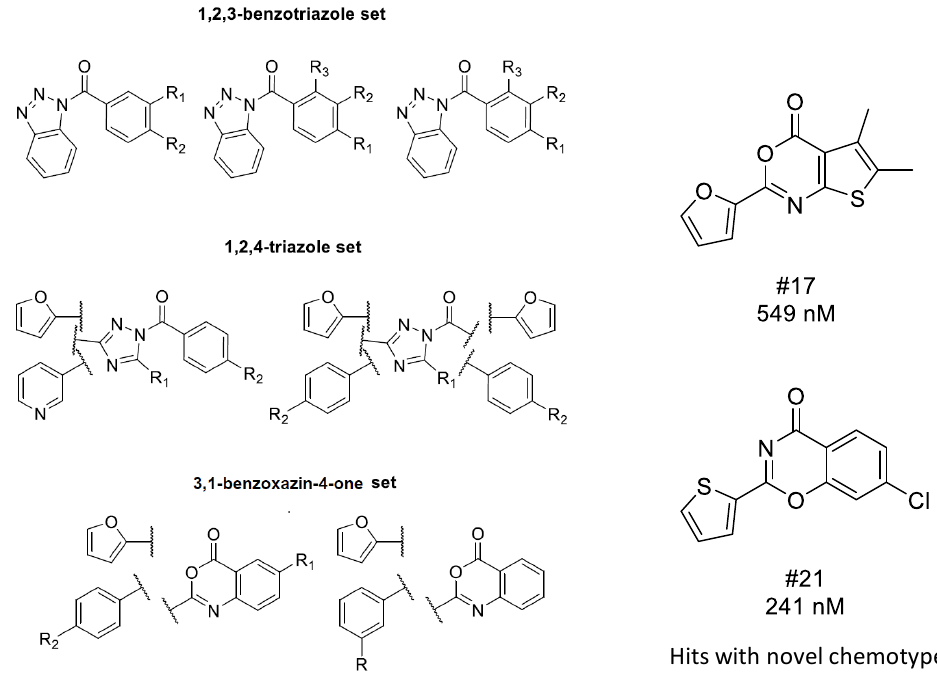
Figure 9. The various clusters used in the pharmacophore model building and the resulting novel chemotypes of C1s inhibitors.